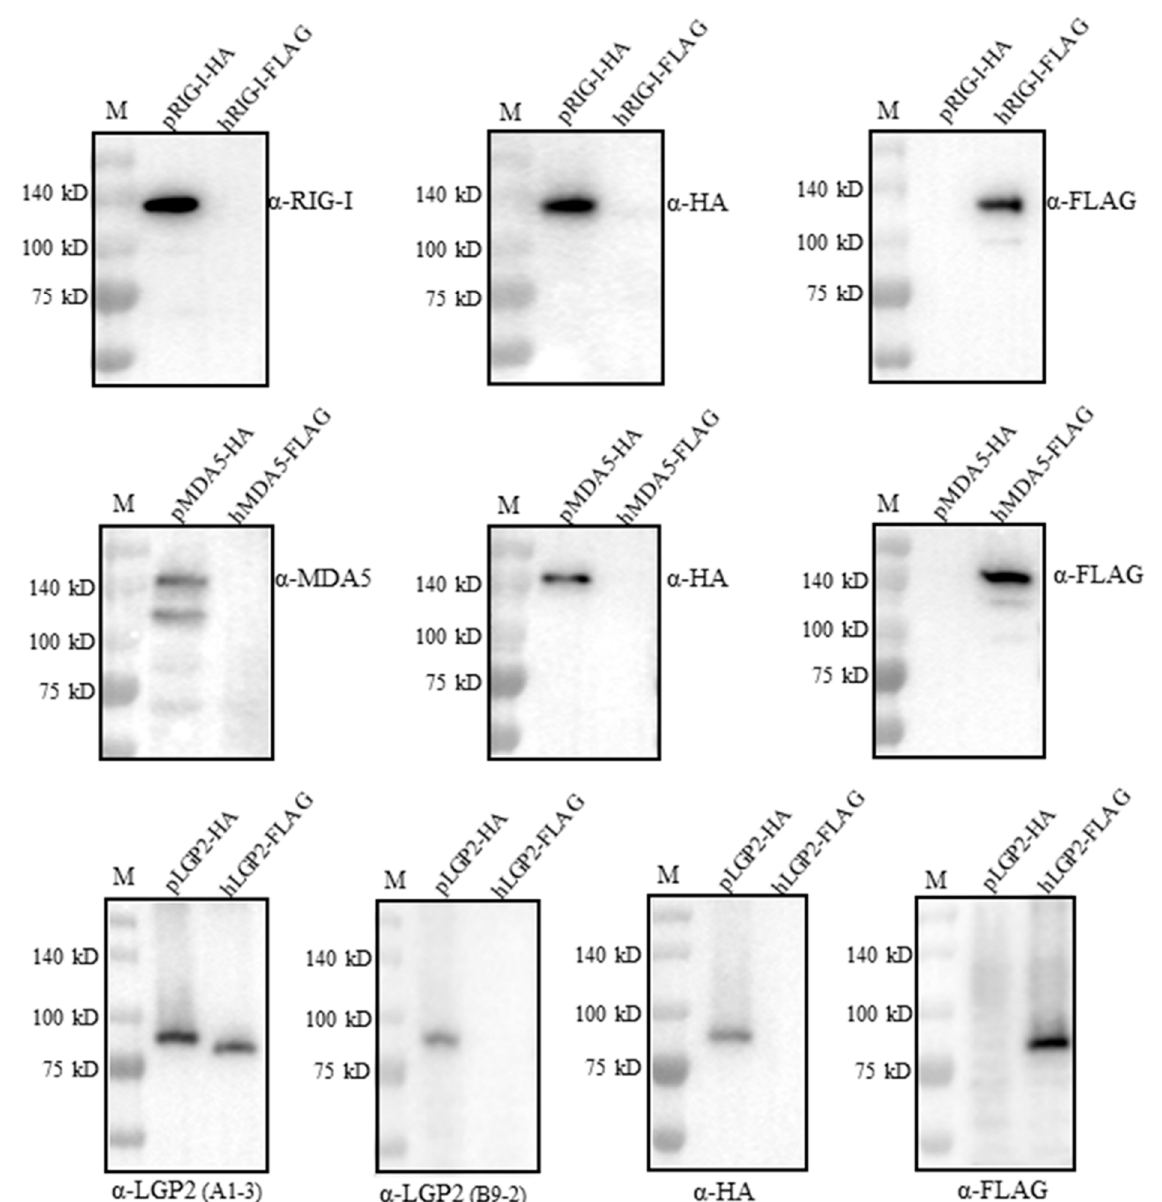
Figure 5. Examination of the cross-reactivity with human RLR proteins by the four porcine RLR mAbs. We transfected 293T cells (2 × 10 5 cells/well) in 24-well cell culture plates with expression plasmids including pcDNA-pRIG-I-2HA, pcDNA-pMDA5-2HA, pcDNA-pLGP2-2HA and pcDNA-hRIG-I-3FLAG, pcDNA-hMDA5-3FLAG and pcDNA-hLGP2-3FLAG (1 μ g each) for 24 h. The cell lysates were analyzed by Western blotting. The porcine RLR protein expressions were confirmed by HA mAb, whereas human RLR protein expressions were confirmed by FLAG mAb. The protein markers are labeled on the left.